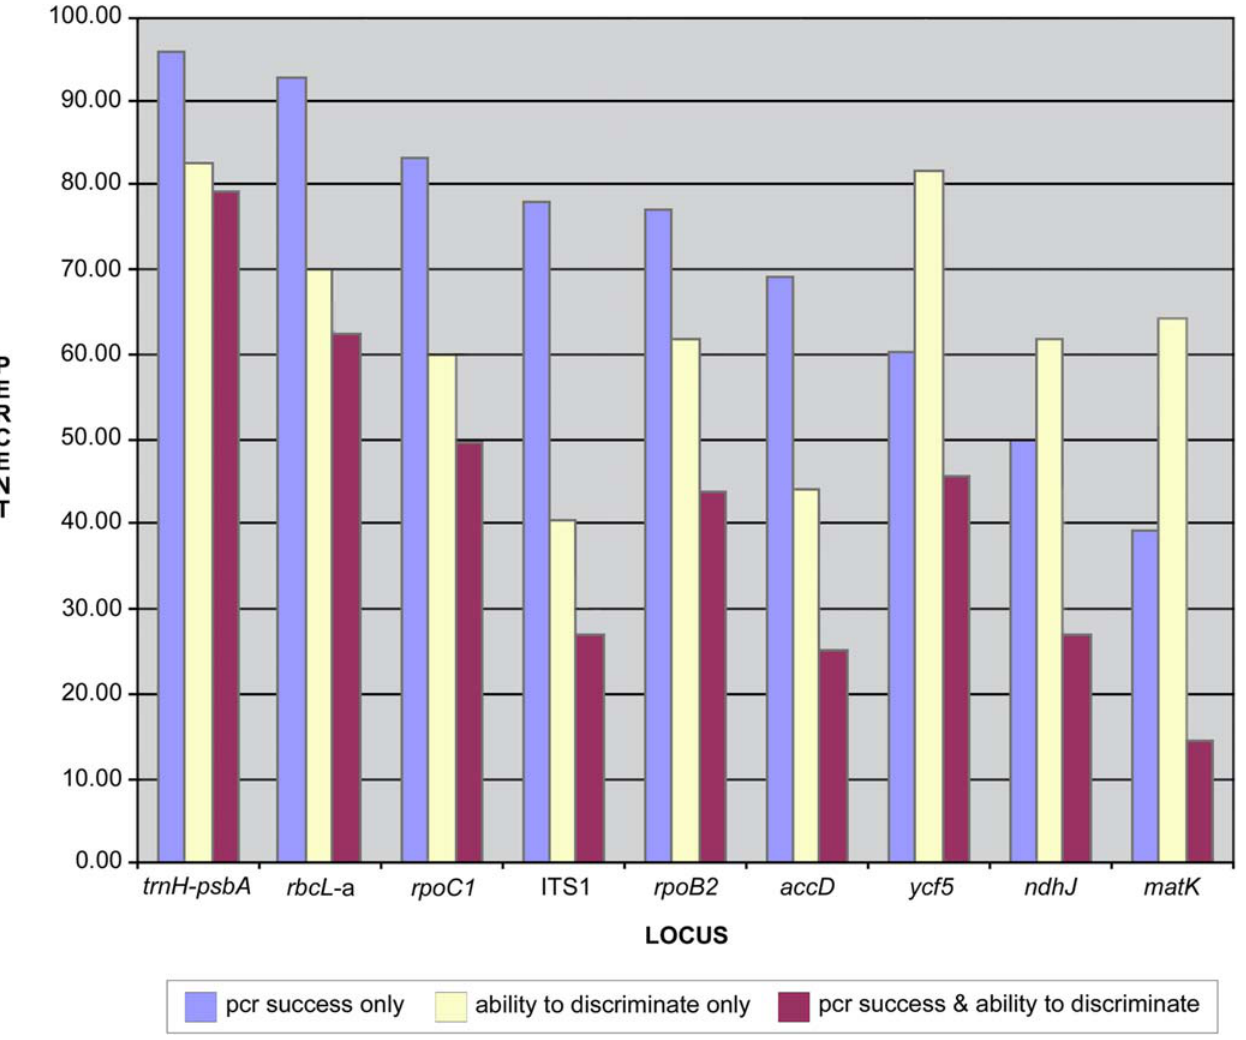
Figure 2. Properties of nine plant loci tested as putative barcodes. Blue bars indicate PCR success; yellow bars indicate percent success in differentiating between species of a pair; maroon bars indicate PCR success combined with the ability to differentiate between species of a pair.